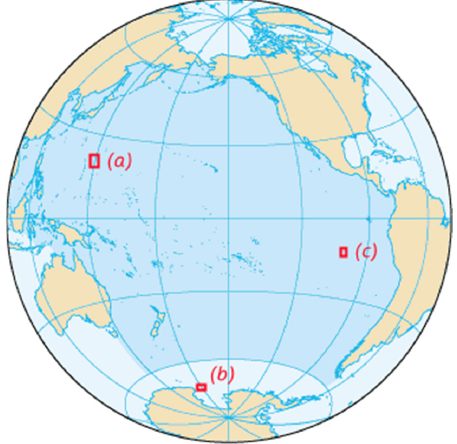
Figure 3. Location of the acquired bathymetry data in (a) West Pacific, (b) Southern Ocean, and (c) East Pacific. Table 1. The parameters of the acquired bathymetry data.